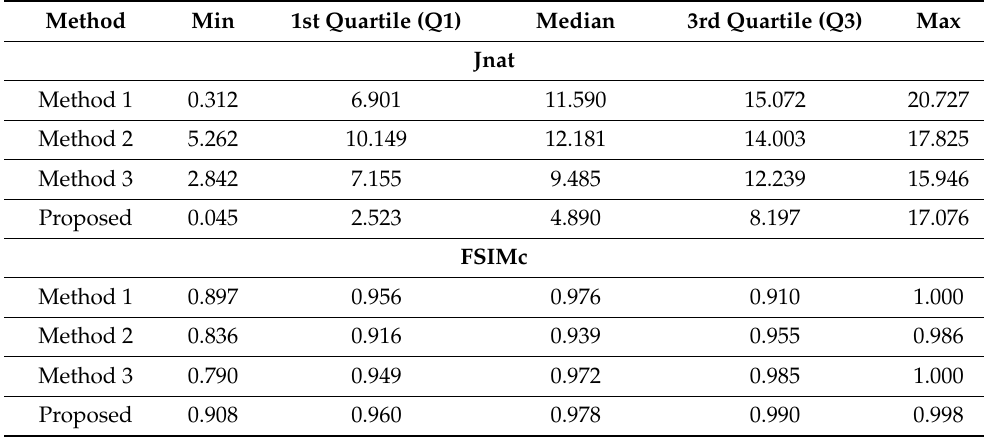
Table 6. Descriptive statistics of the Jnat and FSIMc indices for the deuteranopia case considering the McGill’s Flowers and Fruits data sets (in total 195